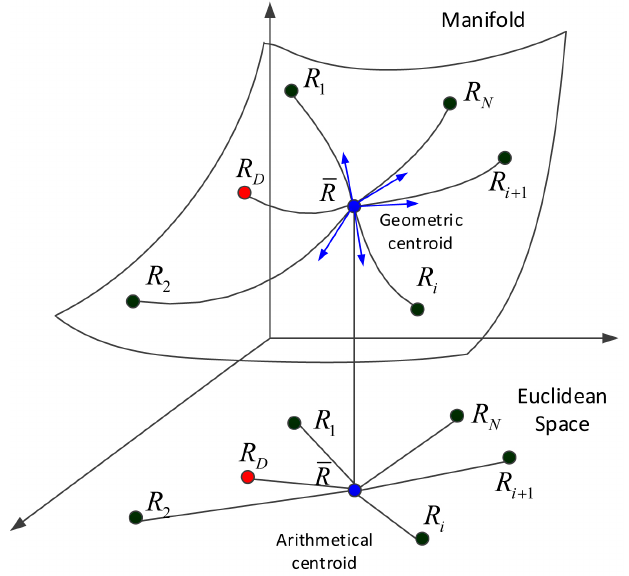
Figure 3. Geometrical interpretation of traditional distances in Euclidean space, and geometric divergences in manifold space, where R represents the traditional distance or geometric divergence of each element.